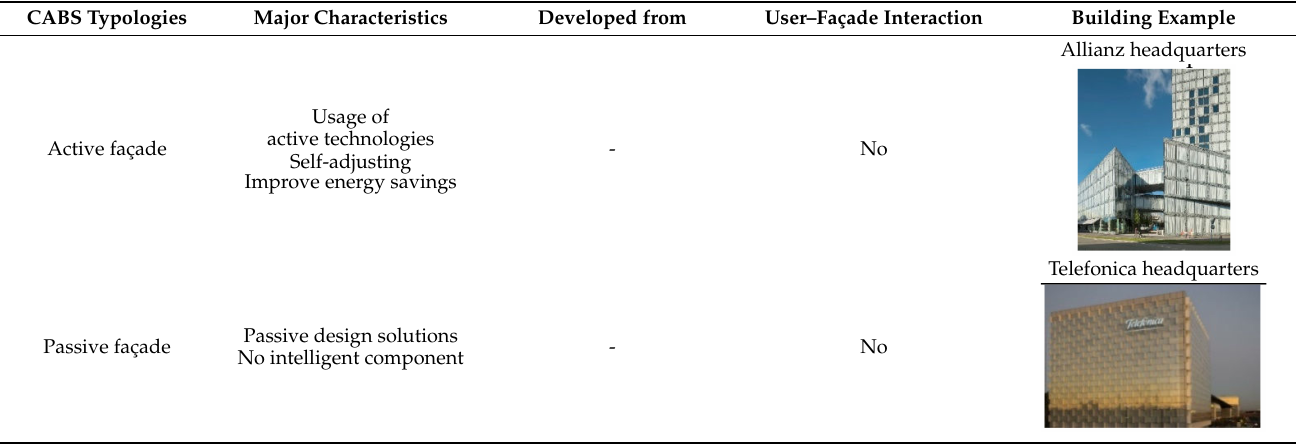
Table 1. CABS typologies [8], amended by the authors,